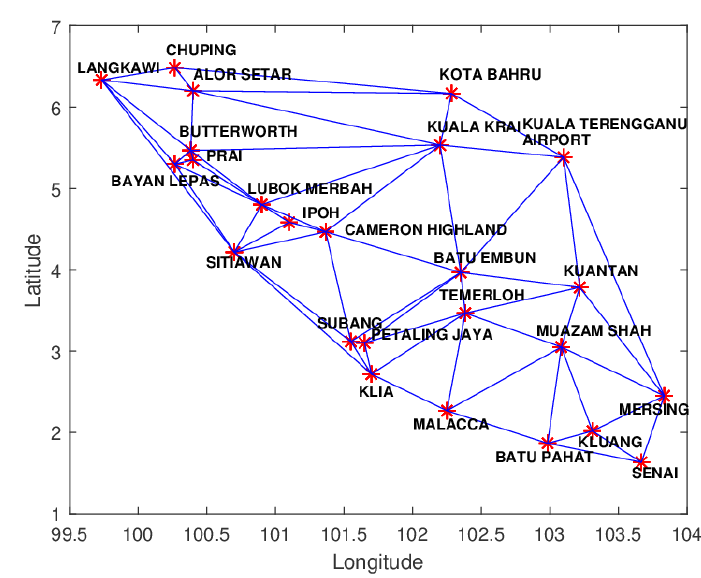
Figure 28. Delaunay triangulation of rainfall data. Figure 29 shows the 3D linear interpolant of the rainfall data for each month. The surface of rainfall distribution in Malaysia of cubic Timmer triangular patches according to each month is shown in Figure 30.